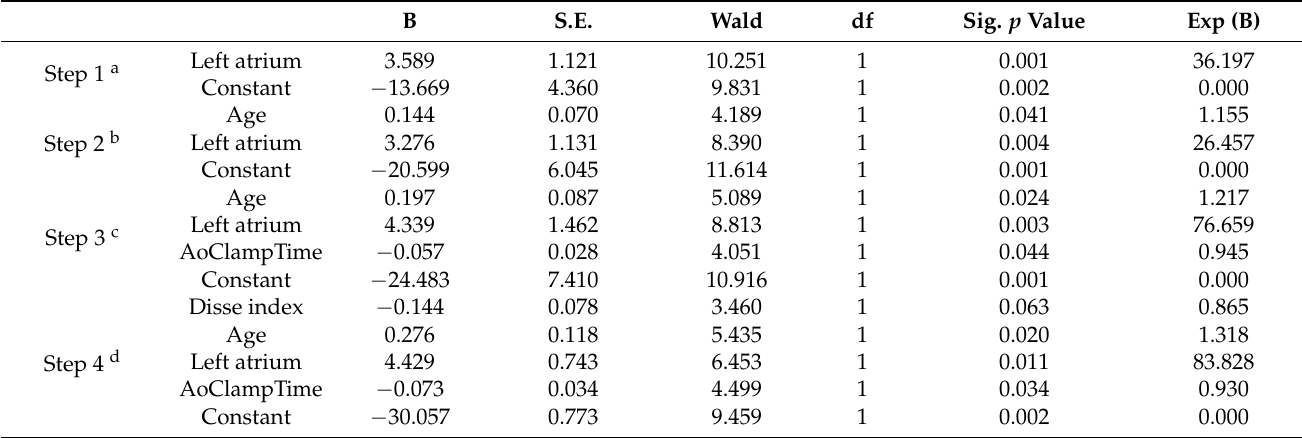
Table 4. Predictors of the combined endpoint (postoperative complications or length of stay > 10 days) in binary logistic re-